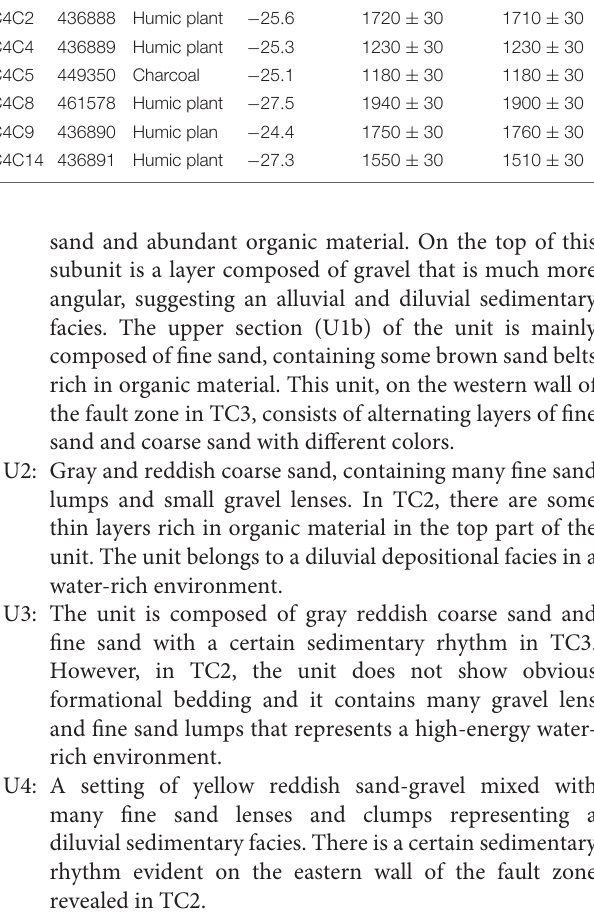
Measured Conventional (o/oo) radiocarbon